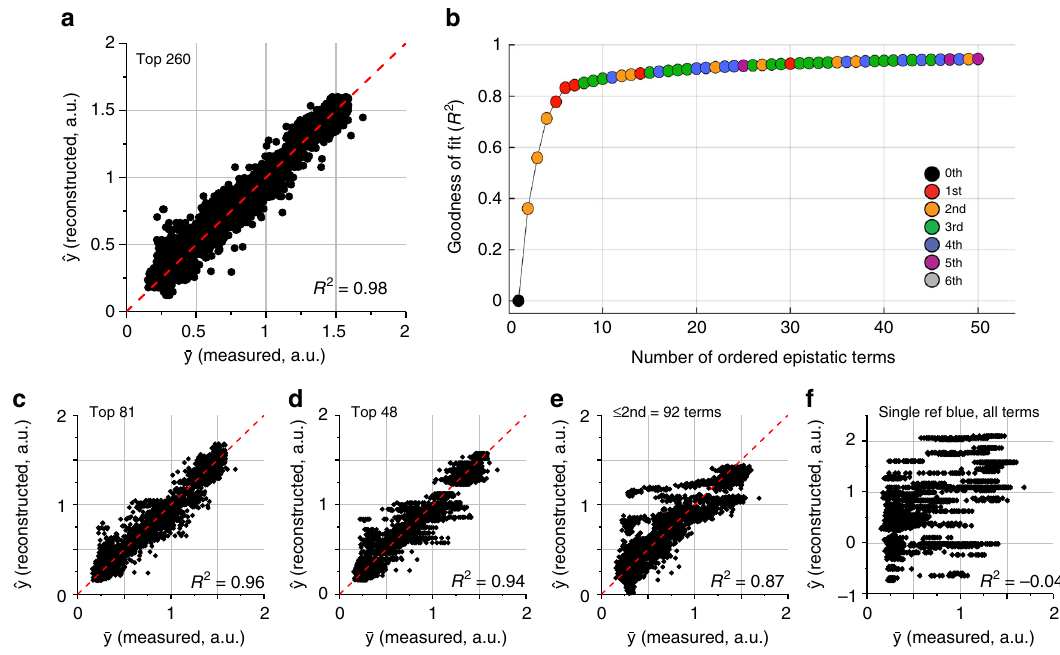
y (measured, a.u.) y (measured, a.u.) Fig. 3 Sparsity in background-averaged (but not single-reference) epistasis. a reconstruction of all phenotypes from the 260 signi fi cant background averaged epistatic terms displays excellent agreement with measured data (goodness-of- fi t R 2 = 0.98, see “ Methods ” ). b A plot of goodness-of- fi t against number of included epistatic terms arranged by degree of contribution, indicating extraordinary sparsity in information content. Colors show the order of epistasis. c , d Consistent with sparsity, reconstruction of phenotypes with the top 81 ( c ) or top 48 ( d ) terms shows good agreement with measured data. e Reconstruction with only second order terms shows poorer agreement with data despite larger number of included terms, indicating the relevance of higher-order epistasis. f Single-reference epistasis shows no predictive power in reconstructing phenotypes, indicating lack of sparsity in this form of epistasis. Noise analysis for single reference epistasis for different genotypes as a reference yields highly variable numbers of signi fi cant terms. The plot shows the reconstruction for the parental blue genotype, for which we recover a mere 31 signi fi cant terms. Phenotypic reconstruction is poor and exhibits discrete levels due to the low number of epistatic terms